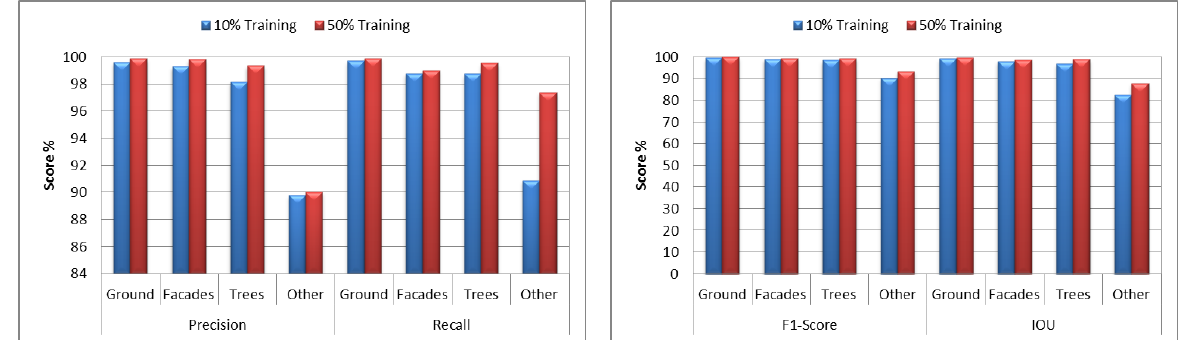
Figure 8. Precession, Recall, and F1-score from for 10% and 50% training.